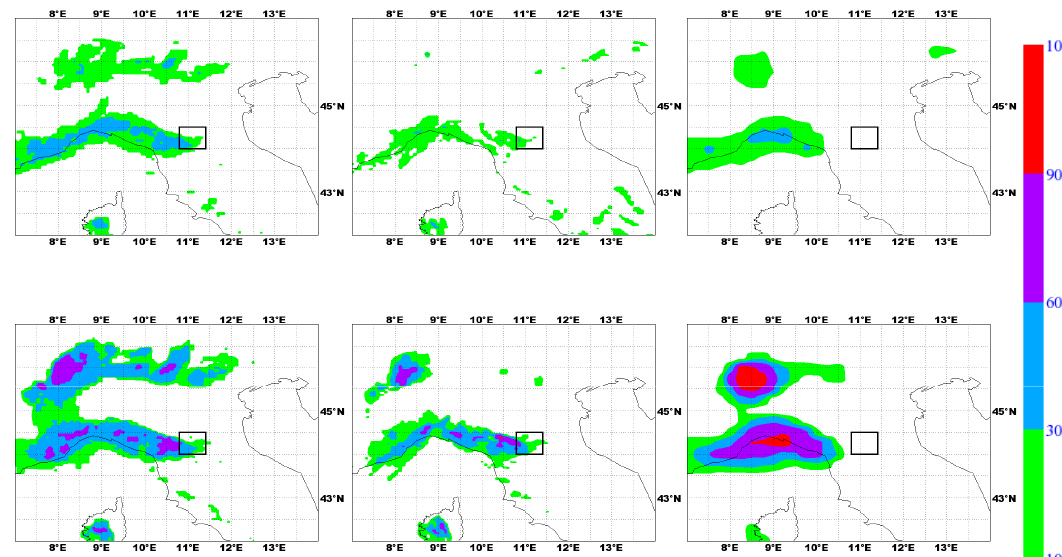
Fig. 4. Maps of probability of precipitation exceeding 20mm in 6h obtained at long ( + 84h, top panels) and short ( + 36h, bottom panels) fore- cast ranges: multi-model (left), COSMO-LEPS (middle) and ECMWF global EPS (right) forecasts valid at 00:00UTC, 30 November 2008. Reno River basin is also indicated by the black